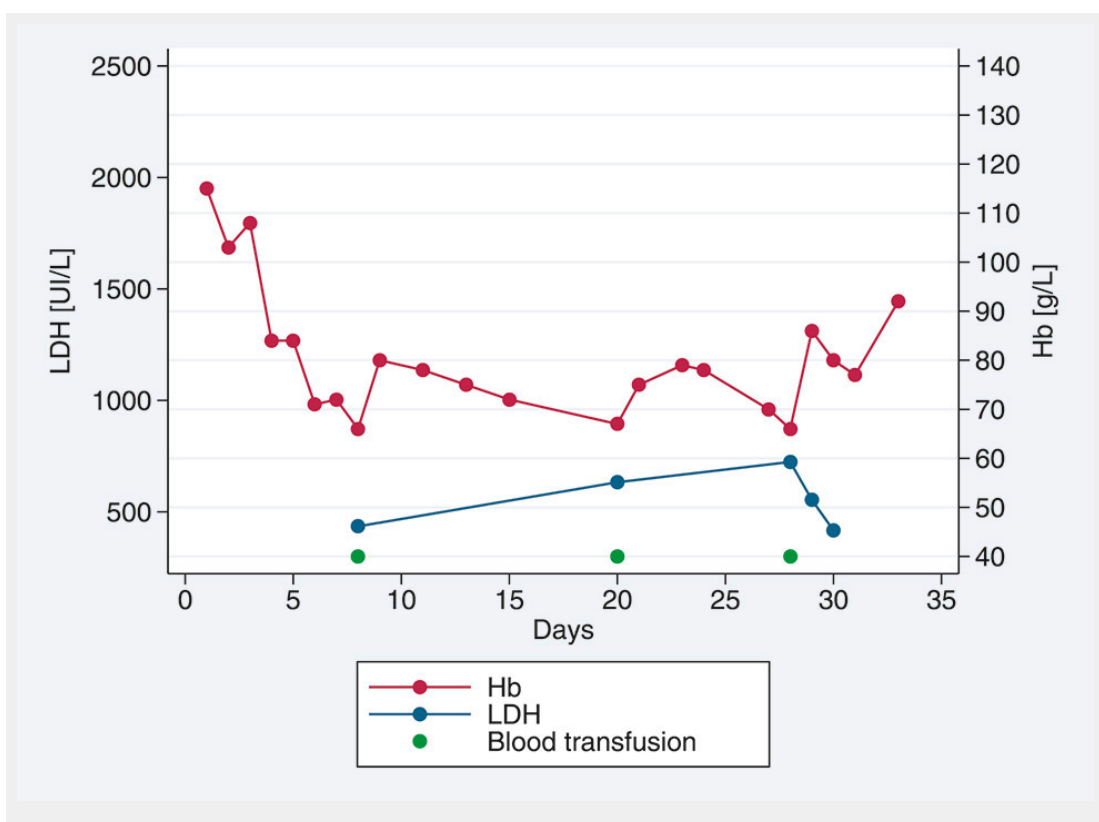
Time course of haemoglobin (Hb) levels and lactate dehydrogenase (LDH) levels in case 4 (persistent